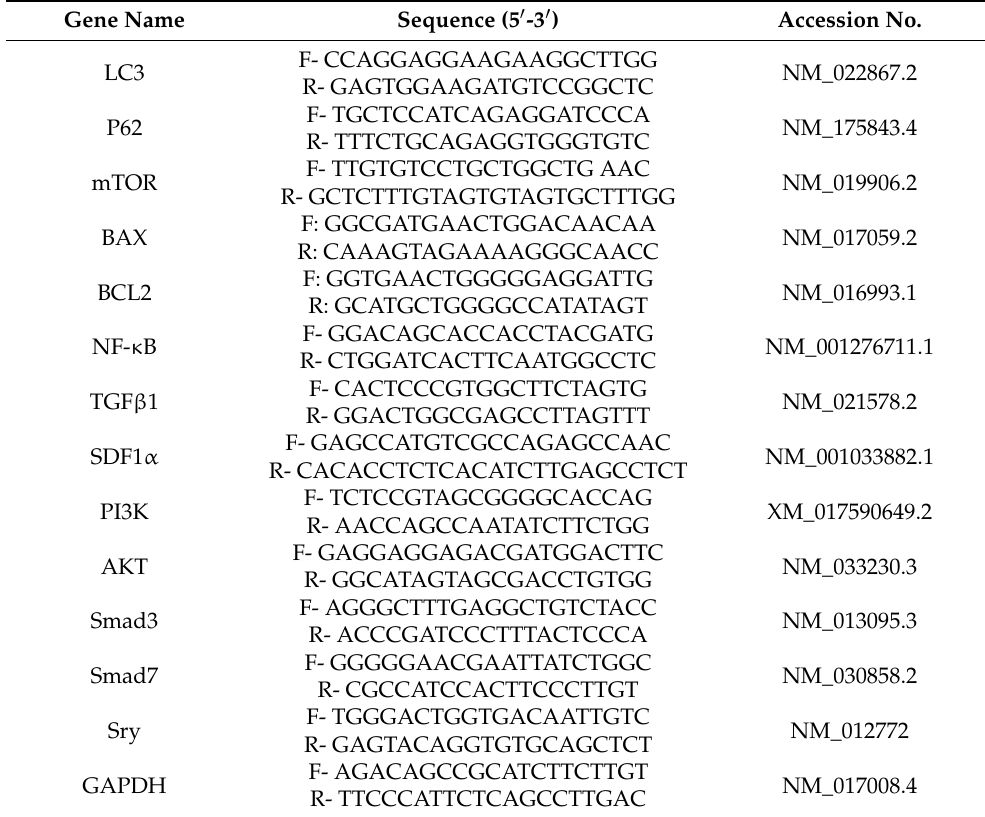
Table 1. Primers used for quantitative